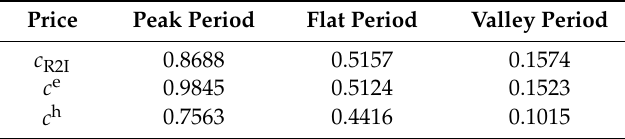
Table 5. Transaction pricing between agents (¥ / kW · h).